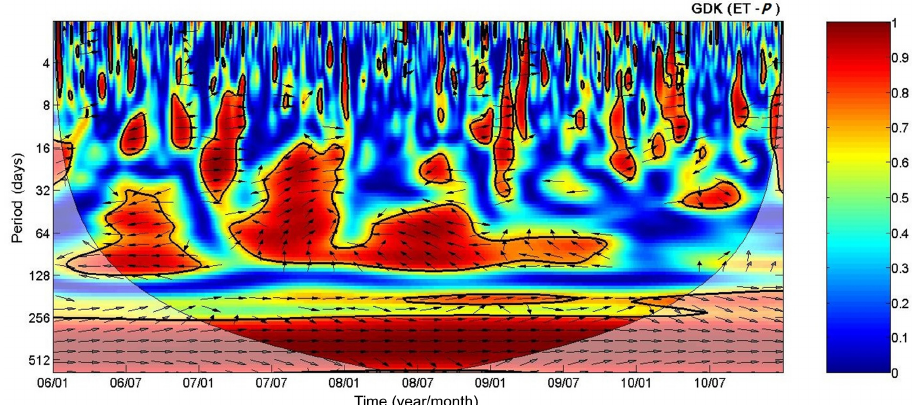
Figure 4. Wavelet coherence spectrum of evapotranspiration (ET) with rainfall ( P ) for the GDK site. The thick solid contour is the 5% significance level against red noise as calculated from a Monte Carlo simulation. Arrows are the relative phase angle with in-phase angle (positive correlation) pointing right, anti-phase angle (negative correlation) pointing left, and P leading ET by 90 ◦ pointing down. The shaded area indicates the cone of influence where the edge effects might distort the